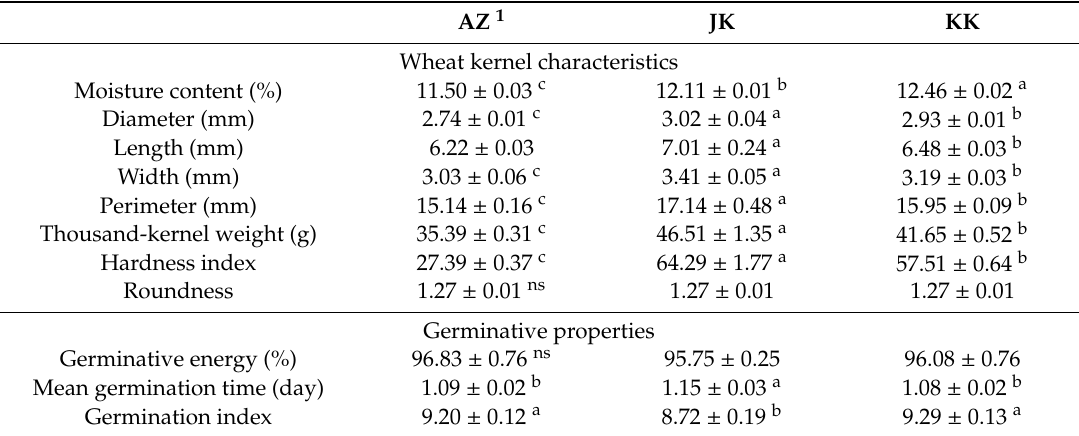
Table 1. Physicochemical and germinative properties of Korean wheat kernels. AZ 1 JK KK Wheat kernel